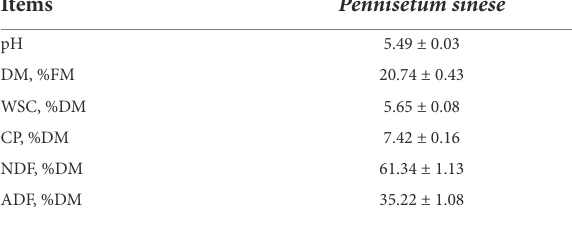
TABLE 1 Chemical composition of cellulase-treated Pennisetum sinese (CTPS) Pennisetum sinese before anaerobic fermentation. Items